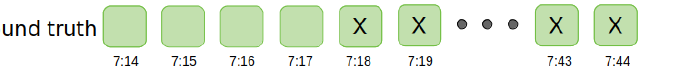
Figure 2. 30-min interval sliced into one-minute time-steps. Interval from 7:14 to 7:44. The symbol X indicates that there is a regulation for this time-step.